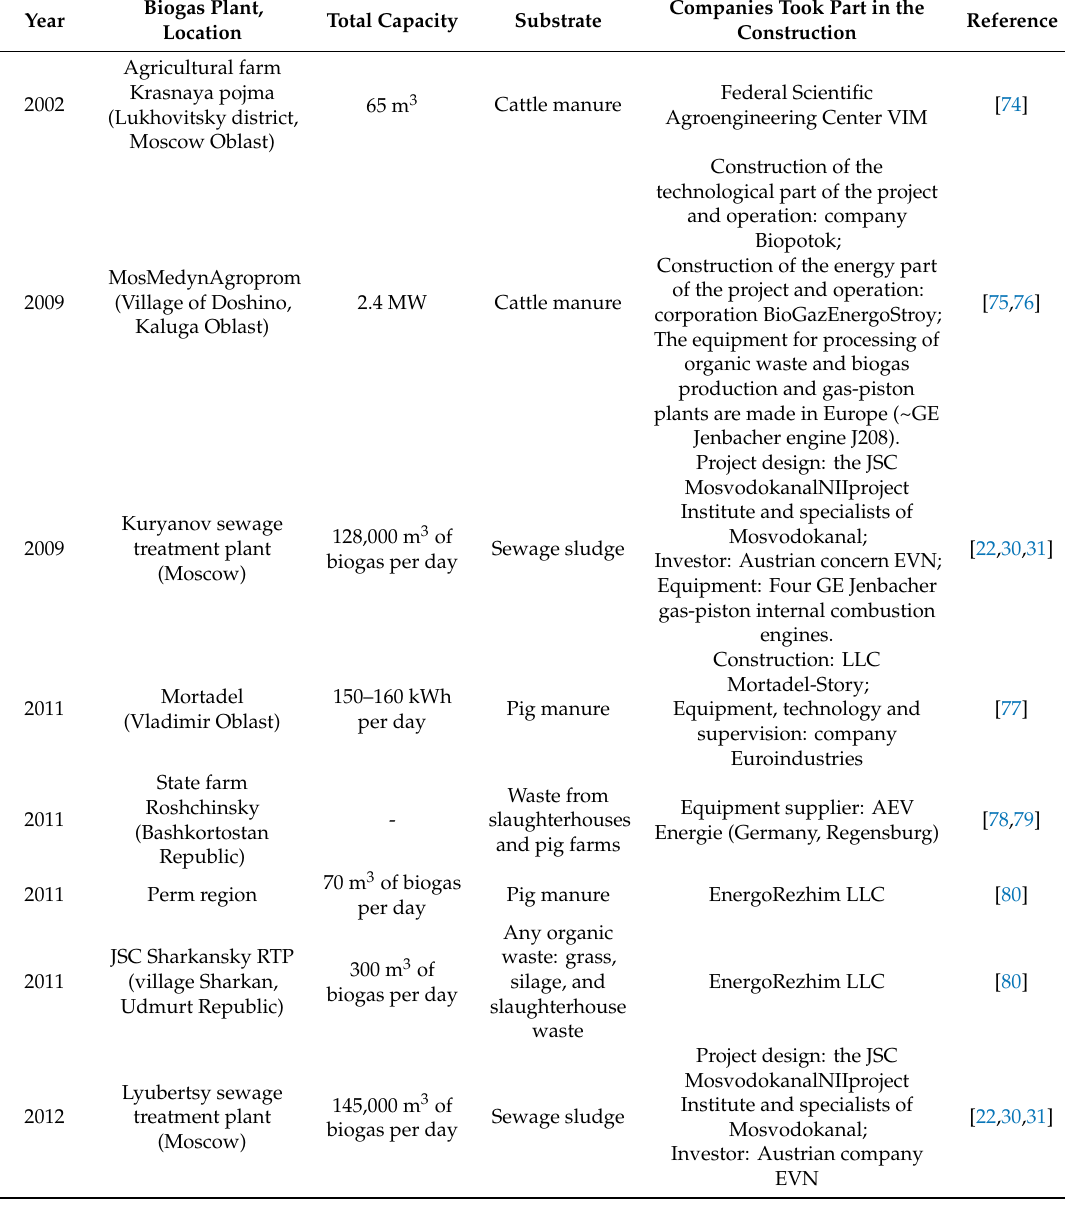
Table A1. The most well-known biogas plants in